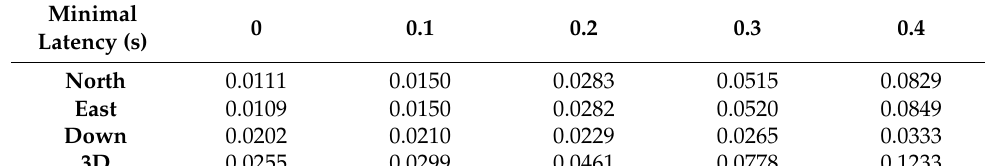
Table 4. RMSE with different minimal latencies of position increments in mode 3.